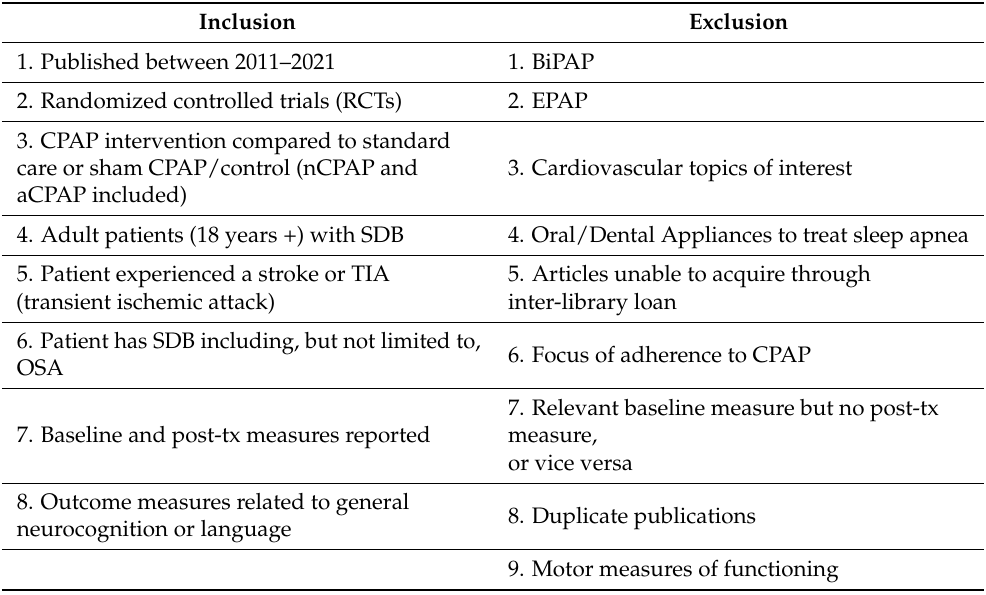
Table 1. Inclusion and Exclusion